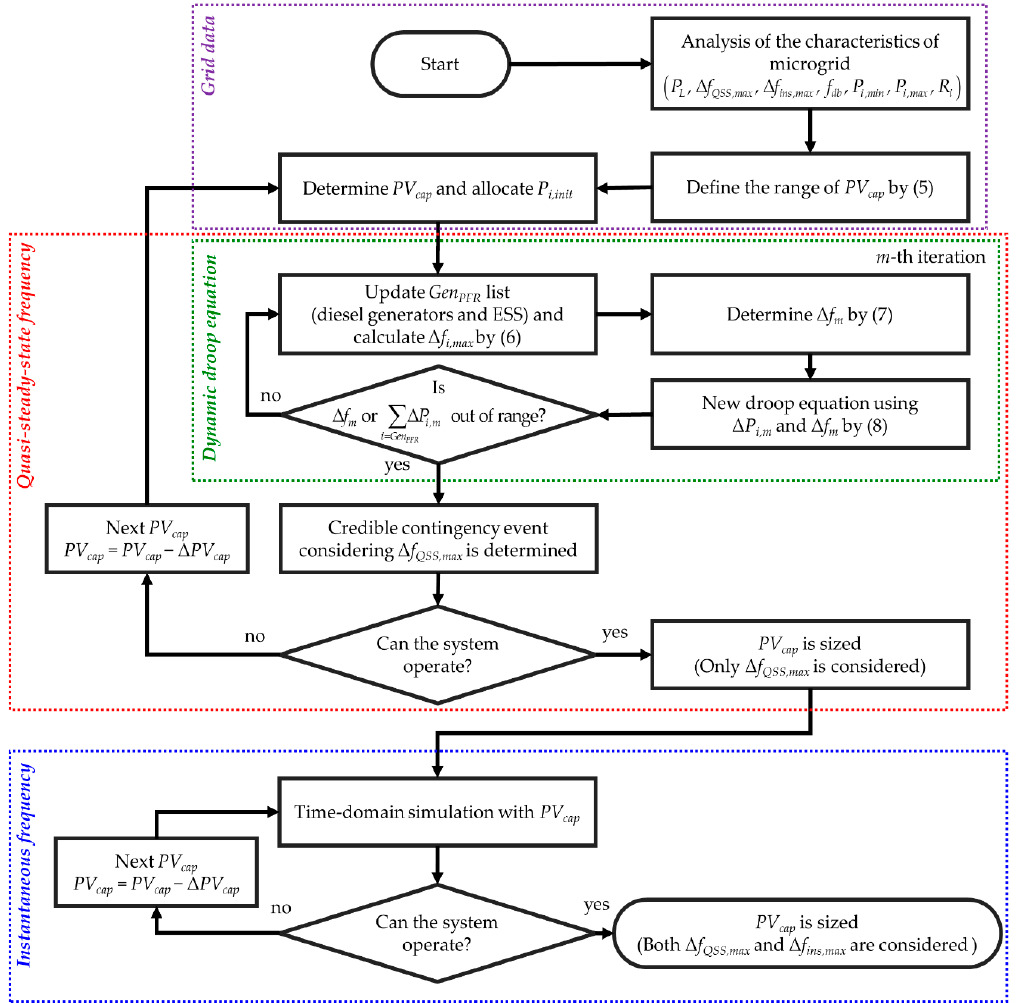
Figure 2. Flowchart of the proposed algorithm.